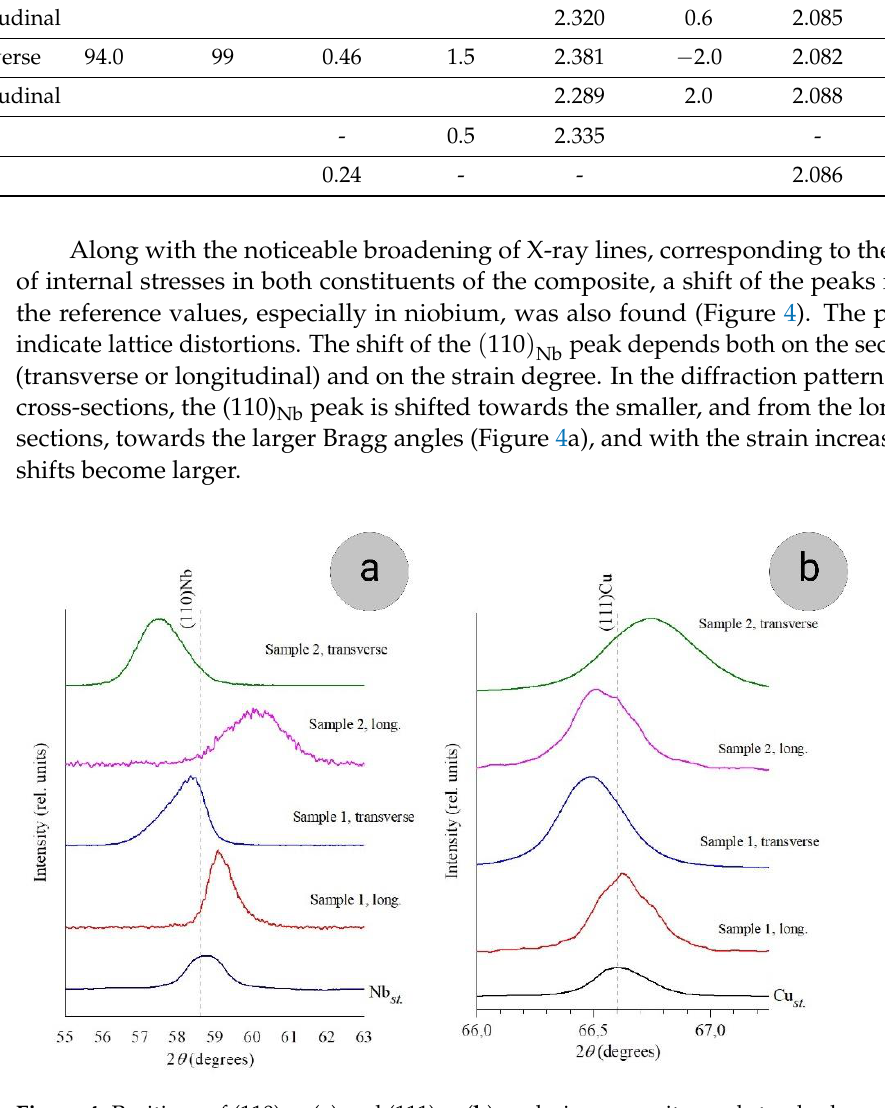
Figure 4. Positions of (110) Nb ( a ) and (111) Cu ( b ) peaks in composites and standards. The Nb crystal lattice distortion is maximal in the (cid:104) 110 (cid:105) Nb direction. The Nb interpla- nar d 110 distances are elongated in the drawing direction and compressed in the transverse areas. The distortion ( ∆ d ) in the <110> direction was attributed to the slight change in the interplanar spaces d 110 ( Nb ) in Samples 1 and 2 in comparison with the reference value d 110 ( Nb ∗ ) and was calculated as: • 100% With the true strain increasing from 10.2 to 12.5, the ( 110 ) interplanar space dis- Nb tortions both in longitudinal and transverse sections increase by more than a factor of 3 (Table